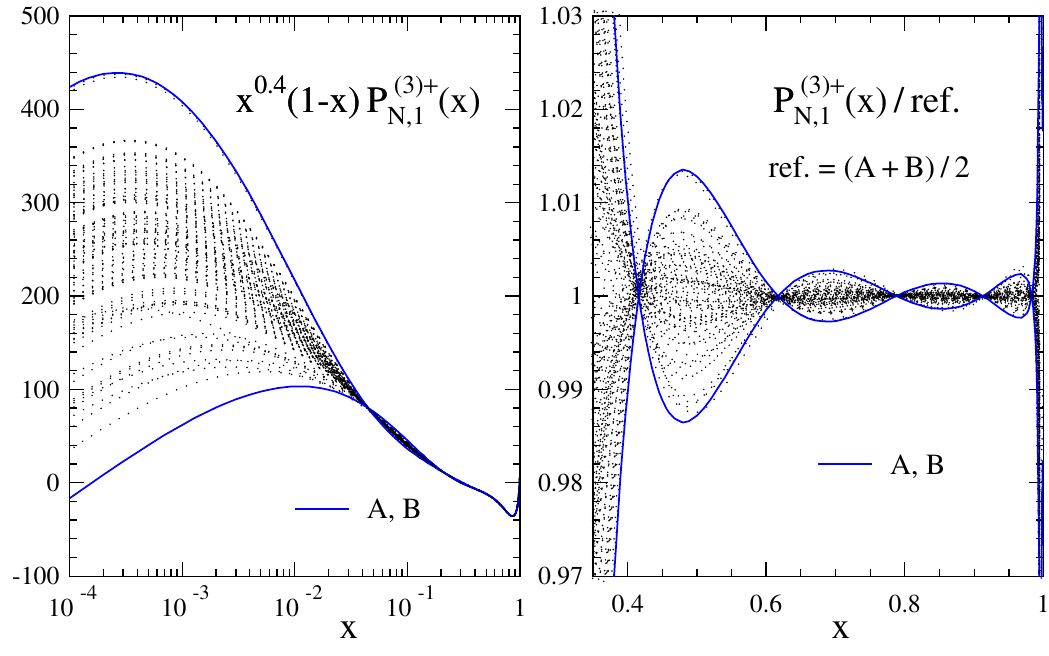
contribution. The ratio in the right panel is shown for a f